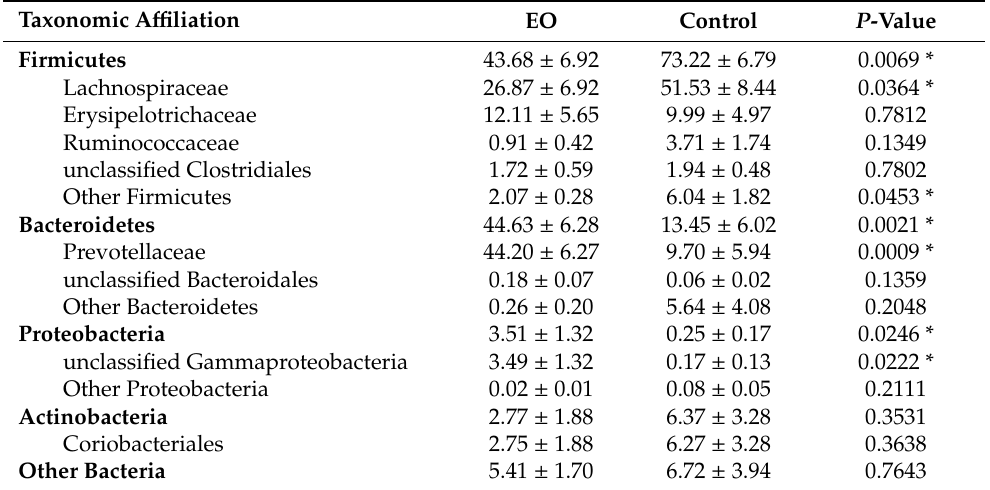
Table 1. Relative abundance (%) of main bacterial taxonomic groups in the rumen of dairy calves fed an EO-supplemented or control diet. Values shown represent mean and standard error of the mean, respectively.